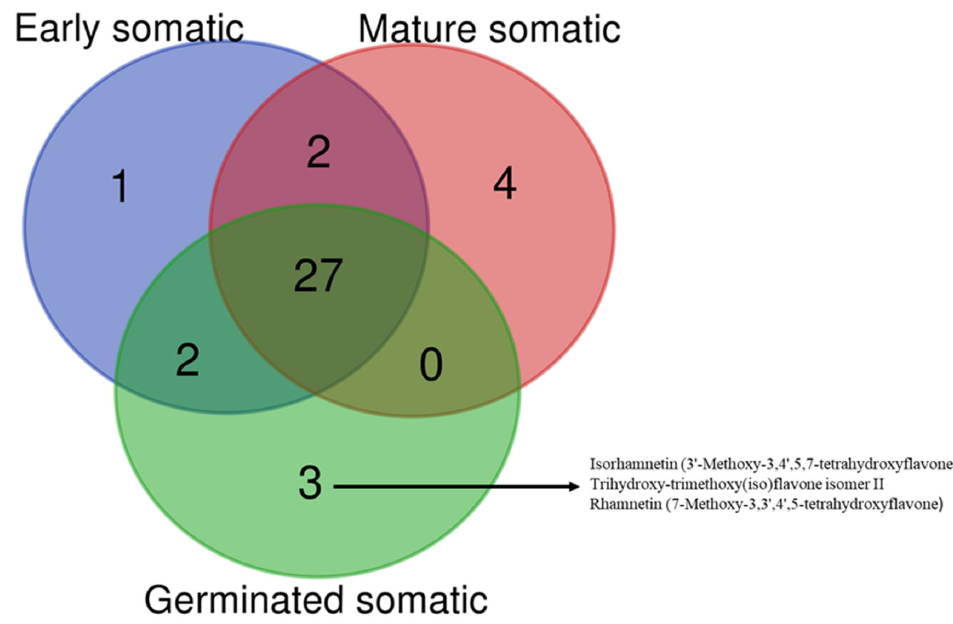
Figure 4. Venn diagram showing the number of compounds identified in the (SoE) tested extracts. Over the last century, most people have come to be familiar with the term antioxi ‐ dant. The term denotes protection against free radical attacks that affect the progression of serious health problems such as cancer, diabetes, or obesity. Several studies have re ‐ ported that antioxidant intake is inversely associated with the development of these dis ‐ eases [56,57]. With this in mind, we determined the antioxidant properties of C. orbiculata extracts, and the results are presented in Table 5. The germinated somatic embryo extract generally showed stronger antioxidant ability than other tested extracts. Ondua et al. [6] reported that the IC 50 values of the methanol extract of C. orbiculata were 3.76 g/mL and 3.35 g/mL for DPPH and ABTS, respectively. Based on their results, our extracts showed weaker free radical scavenging ability than their tested extracts. From Table 5, when the combined scavenger and reduction performance results were obtained, we found an al ‐ most similar order. The obtained results almost agreed with the results of the total phe ‐ nolic and flavonoid content of the tested extracts; therefore, we concluded that phenolics made the main contribution to the radical scavenging and reducing ability. Moreover, some compounds have only been detected in germinated SoE extract, and these are also known to be powerful antioxidants [58,59]. Enzymes are pharmaceutical targets for treating various health problems, including Alzheimer’s disease, obesity and diabetes. In particular, the inhibition of key enzyme abil ‐ ities might alleviate the symptoms of the diseases mentioned above [60]. For this purpose, several compounds have been manufactured as enzyme inhibitors, and most of them are presented on pharmacy shelves. However, synthetic compounds exhibit unpleasant side effects, including gastrointestinal problems and toxicity [61–63]. Therefore, several studies have focused on replacing synthetic inhibitors with natural ones. The tested extracts showed remarkable inhibitory effects on AChE, BChE, tyrosinase, and amylase. The ob ‐ served capabilities of the tested samples can be explained by the presence of some